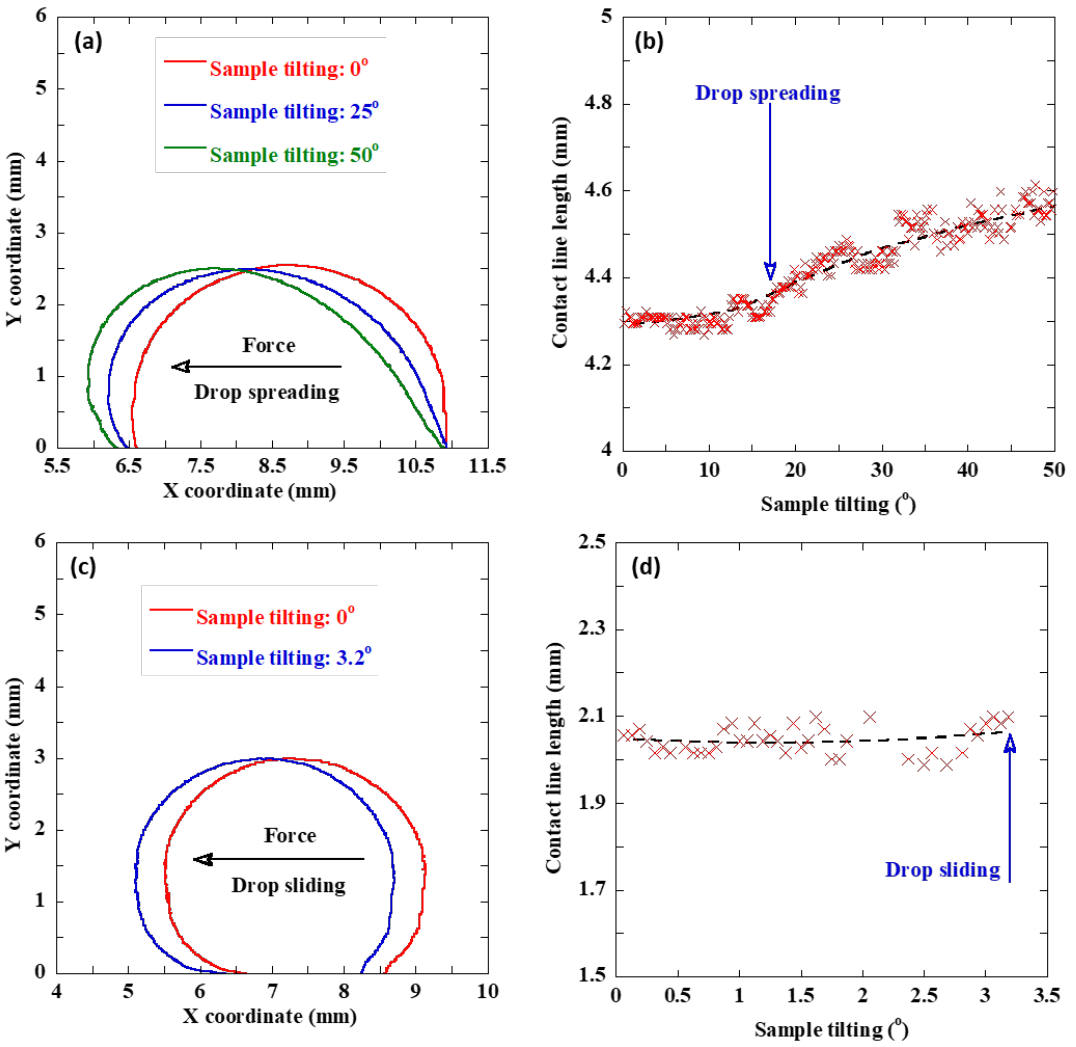
Figure 7. Evolution of water drop ( a ) contour and ( b ) contact line length as a function of tilting angle for the hydrophobic 6P/1F surface. Evolution of water drop ( c ) contour and ( d ) contact line length as a function of tilting angle for the superhydrophobic 6P/1F/2Si surface.